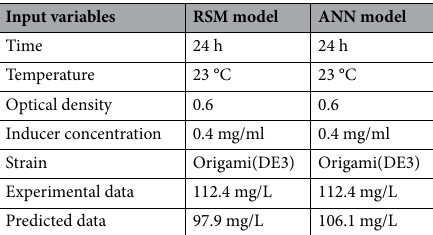
Table 4. Optimum condition and strain for soluble production of anti